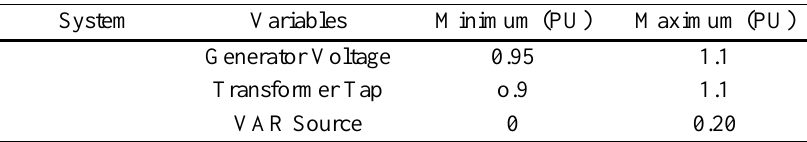
Table 1. Constraints of control